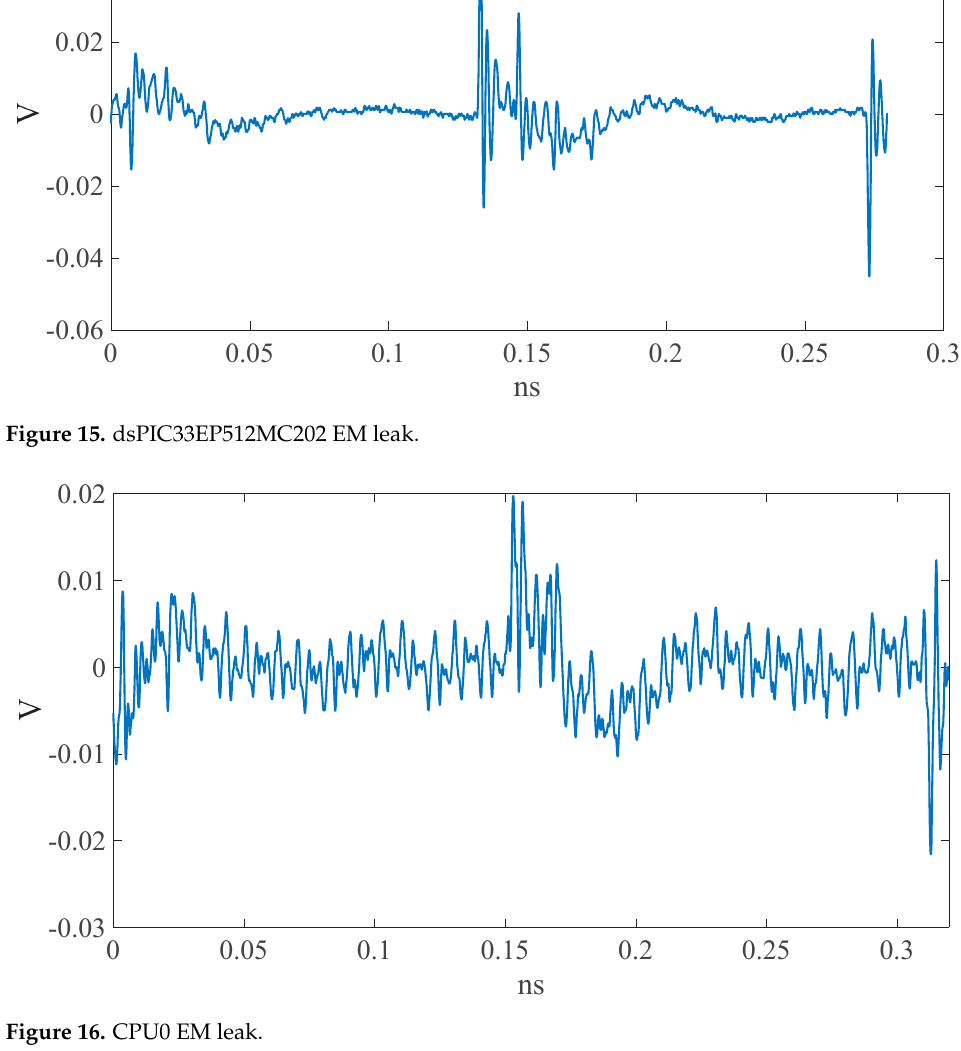
Figure 16. CPU0 EM leak. Figure 16. CPU0 EM